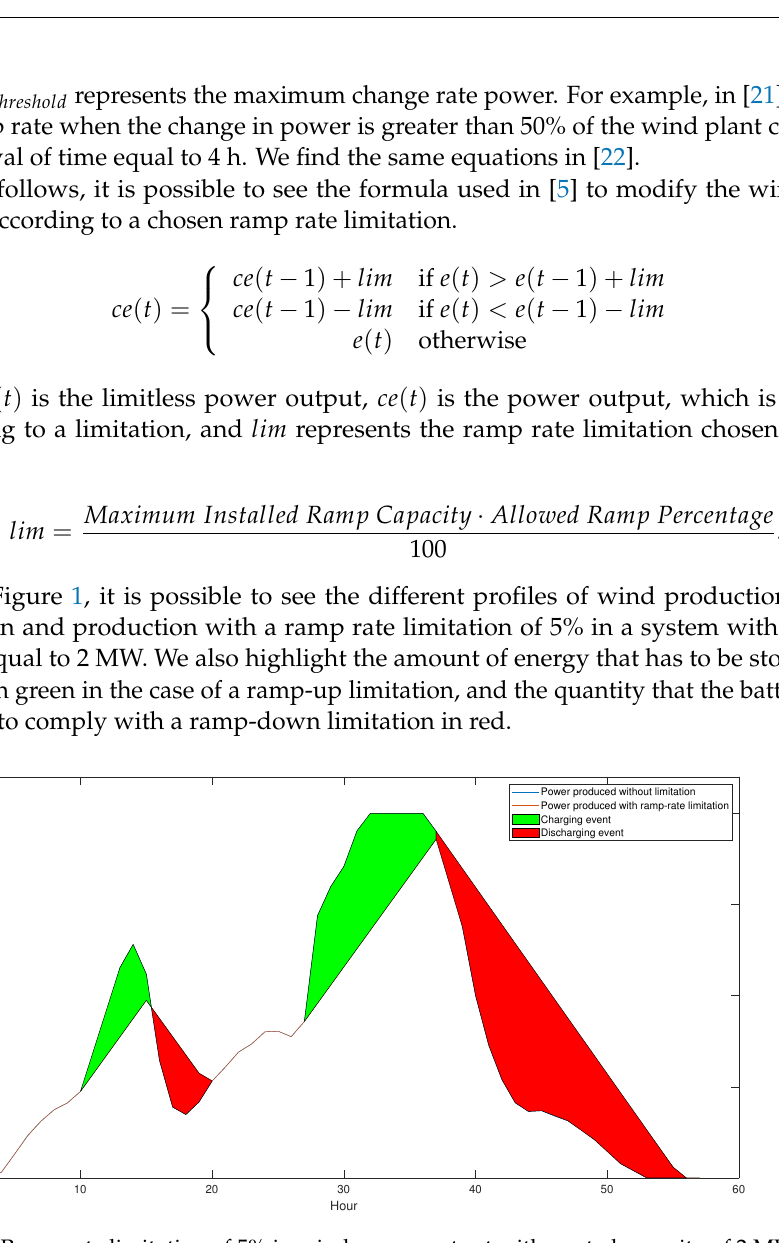
Figure 1. Ramp rate limitation of 5% in wind power output with a rated capacity of 2